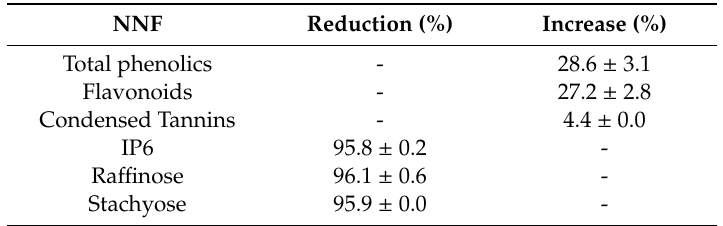
Table 5. E ff ect of germination on